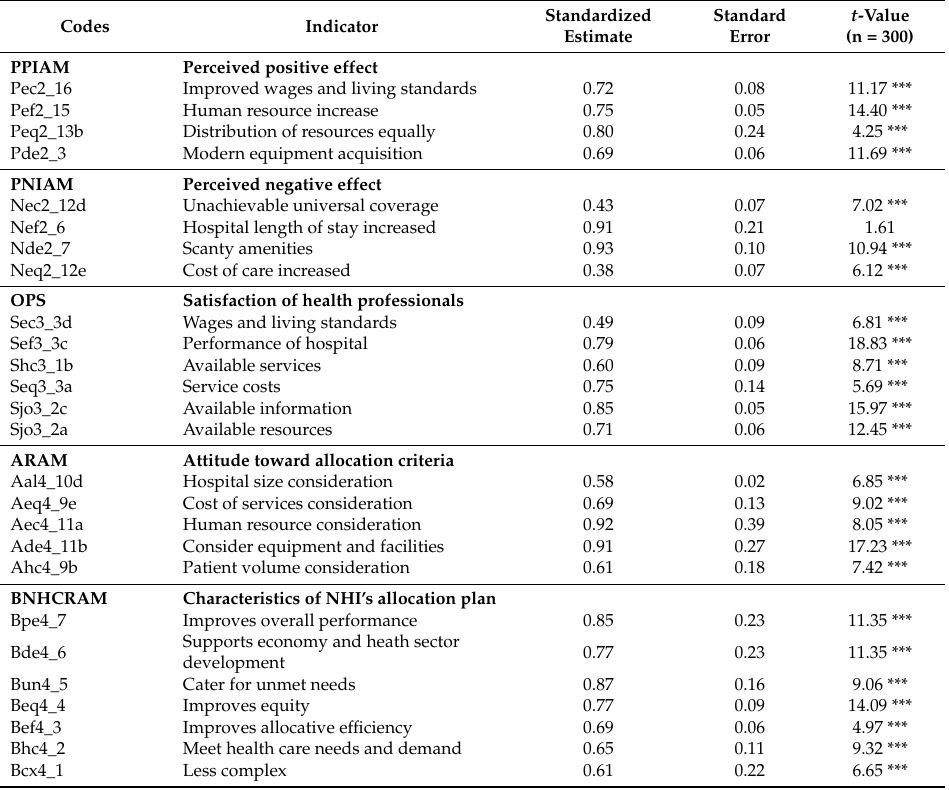
Table 2. Standardized parameter estimates of measurement indicators by latent